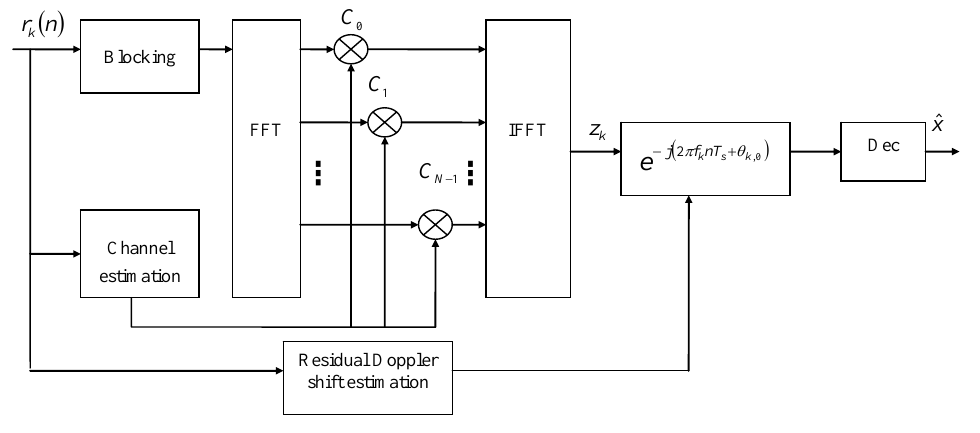
Figure 2. Basic FDE receiver structure for the single carrier-system.